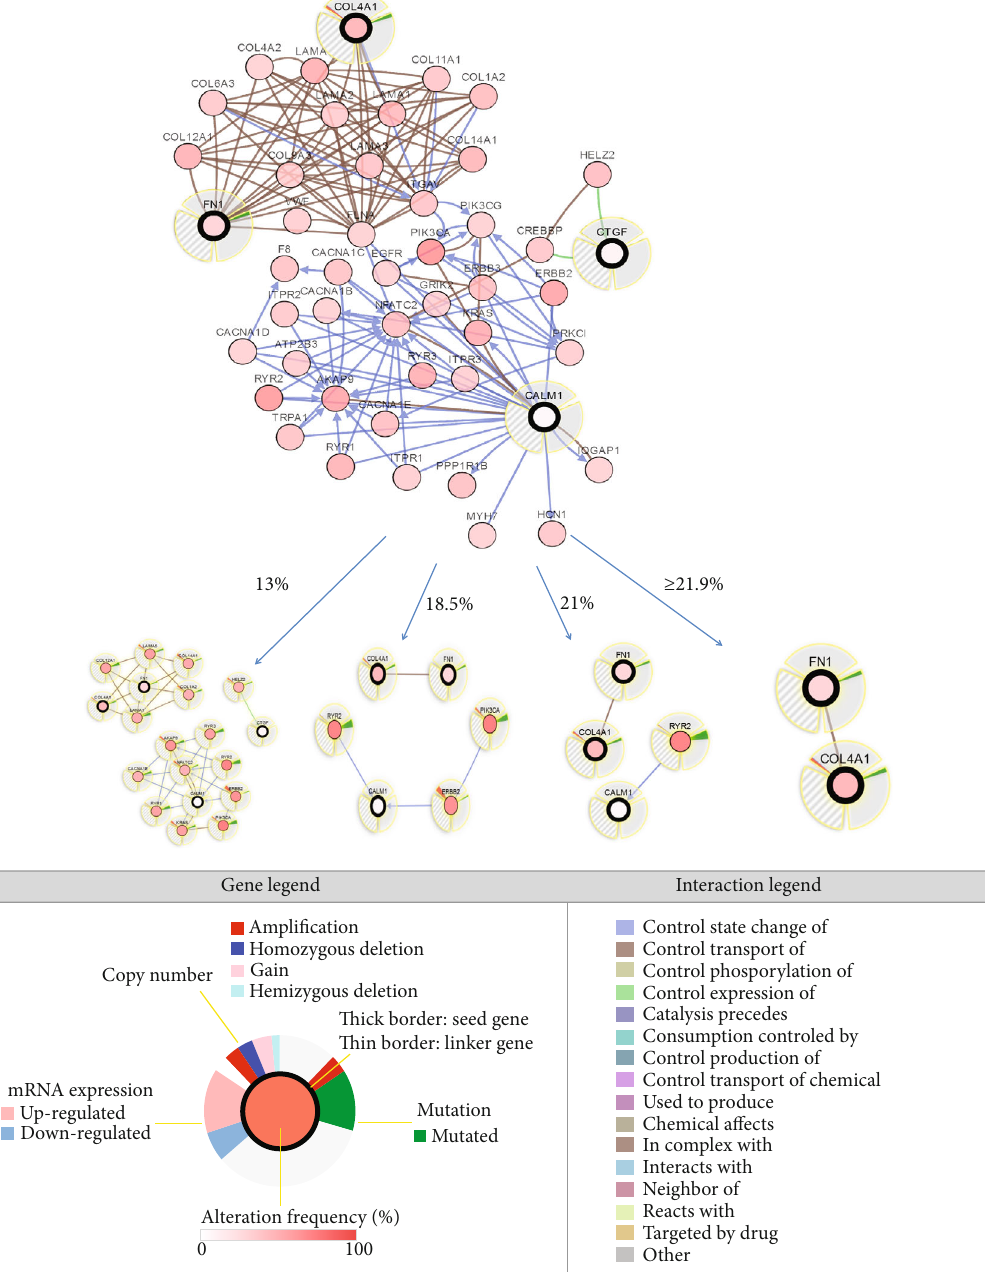
Figure 7: Display of neighboring genes connected to THBS1, FN1, CALM1, COL4A1, CTGF, and IGFBP5 in GC. THBS1, FN1, CALM1, COL4A1, CTGF, and IGFBP5 were used as seed genes (indicated with thick black borders) to automatically harvest all other genes identi fi ed as altered in GC. Multidimensional genomic details are shown for COL4A1, FN1, CTGF, and CALM1 seed genes. Dark red indicates an increased frequency of alterations (de fi ned by mutation, copy number ampli fi cation, or homozygous deletion) in GC. Shown in the fi gure are the full and pruned networks containing all or part neighbors of all query genes generated; the neighboring genes connected to COL4A1, FN1, CTGF, and CALM1 are fi ltered by alteration